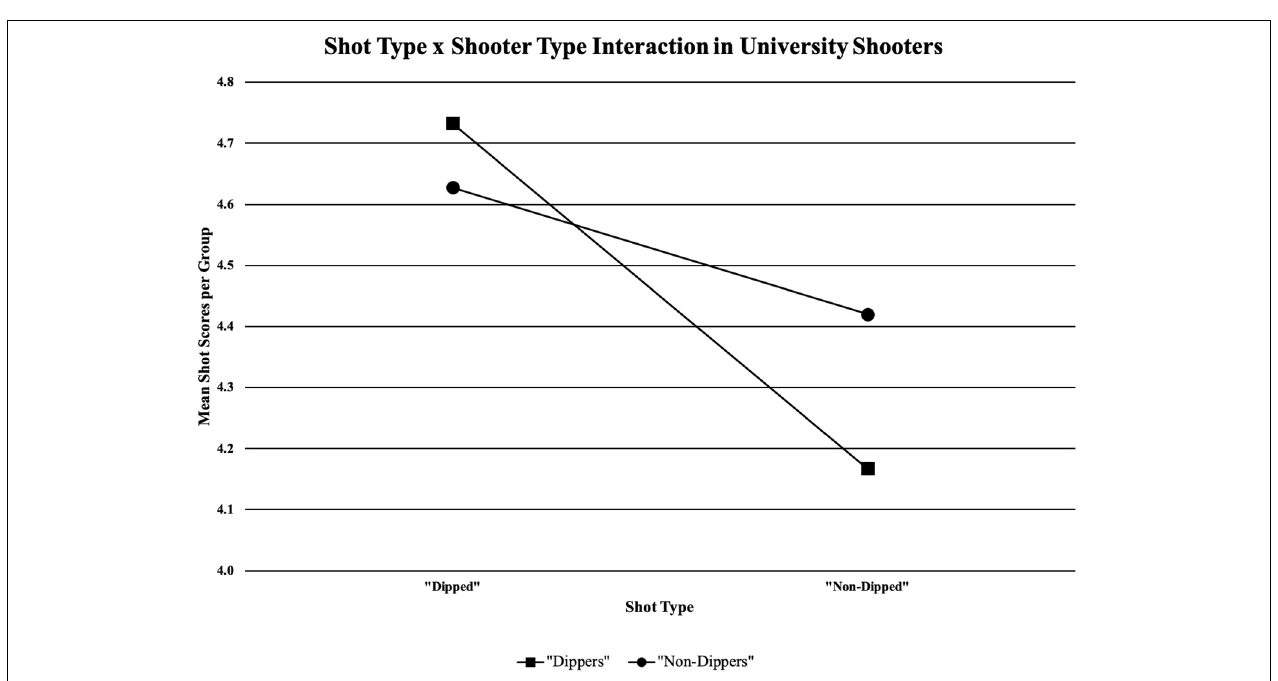
FIGURE 7 | Shooter type (“dipper” and “non-dipper”) and shot type (“dipped” or “non-dipped”) interaction in university shooters; significant results for “dippers” using the “dip” compared to the “non-dip” shooting motion ( p = 0.000); significant results for “non-dippers” using the “dip” compared to the “non-dip” shooting motion ( p =